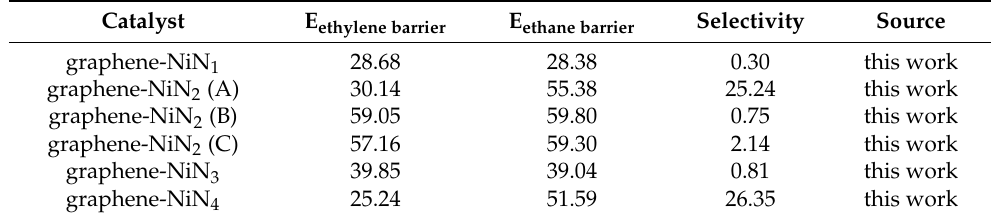
Table 3. Rate-controlling step energy barriers for acetylene hydrogenation catalyzed by graphene- NiN x (x = 1, 2, 3, 4) catalysts (energy unit: kcal/mol). Catalyst E ethylene barrier E ethane barrier Selectivity Source graphene-NiN 1 this work graphene-NiN 2 (A) this work graphene-NiN 2 (B) this